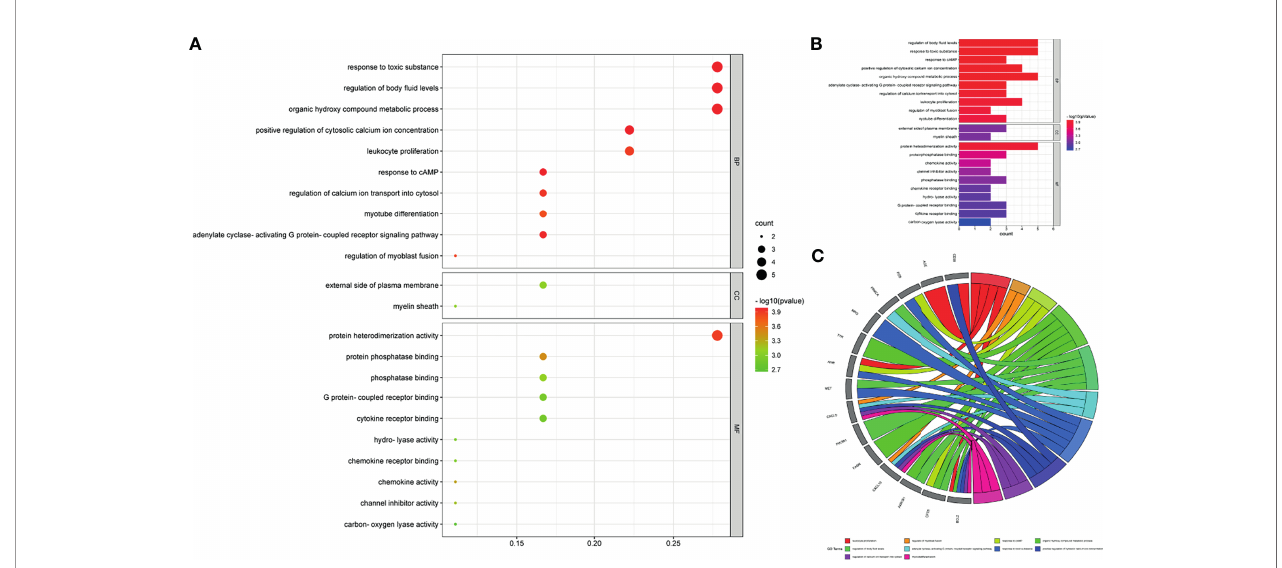
FIGURE 4 | Enrichment annotation exhibited GO data of luteolin in treating PC and COVID-19, as characterized in the bubble graph (A) , histogram graph (B) , and circle chart (C) .